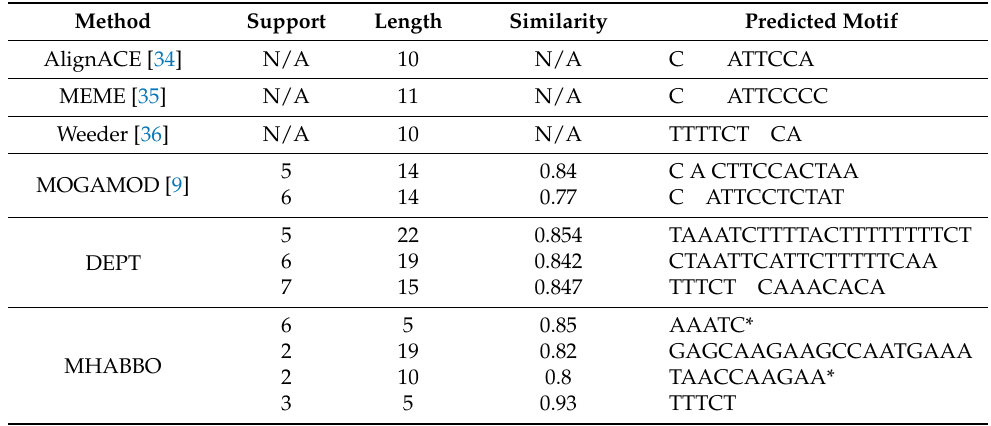
Table 5. Comparisons of the predicted motif with different methods for yst04r.